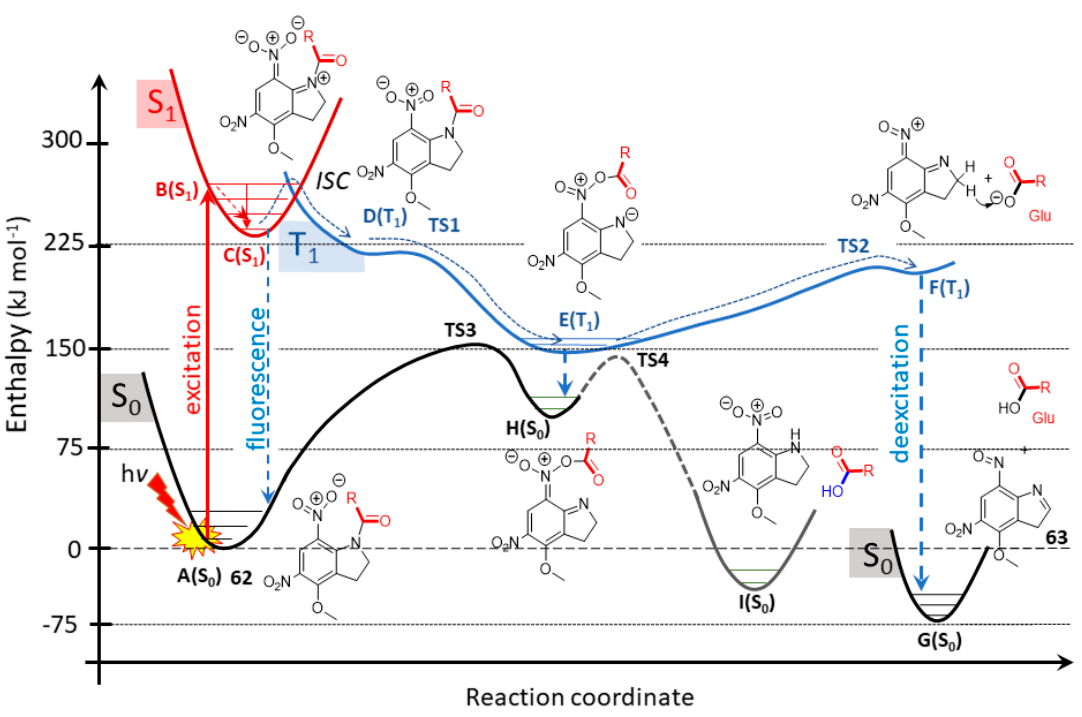
Figure 25. Quantum chemical modelling of the potential enthalpy profile of the singlet (red), triplet (blue) and ground state (black) mechanism for DNI-Glu ( 62 ) at B3LYP/6-31G(d,p)//PCM(water) level of theory. For detailed data see [138].